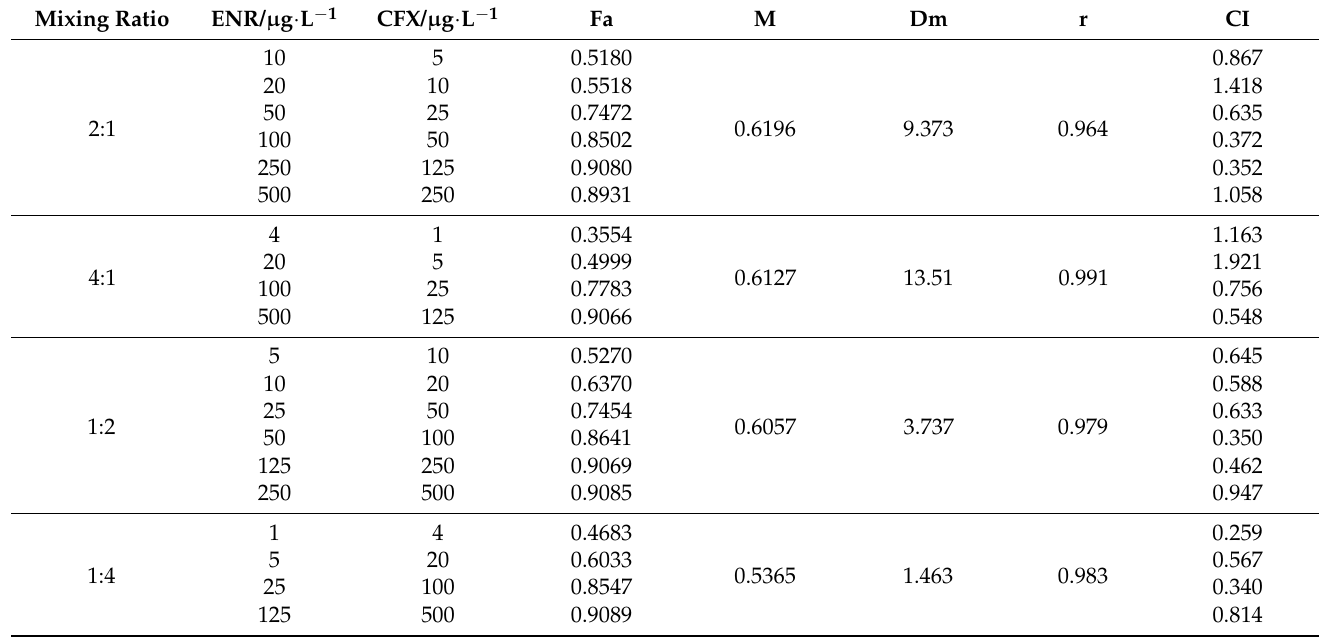
Table 4. CI values and parameters of median-effect plots of binary drug combination enrofloxacin and ciprofloxacin (mixed at ratios of 2:1, 4:1, 1:2, and 1:4) against THLE-2 cells after 72 h incubation.